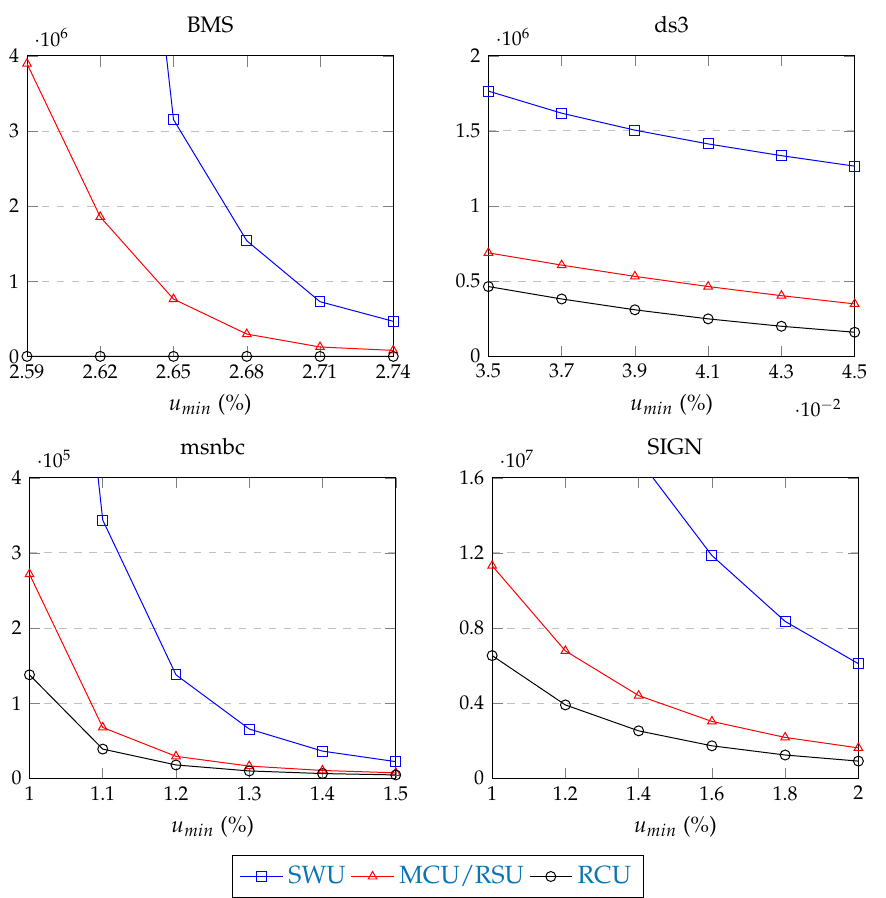
Figure 8. Results of experiment 1: Number of candidate patterns generated by each method to identify the full set of high utility sequential